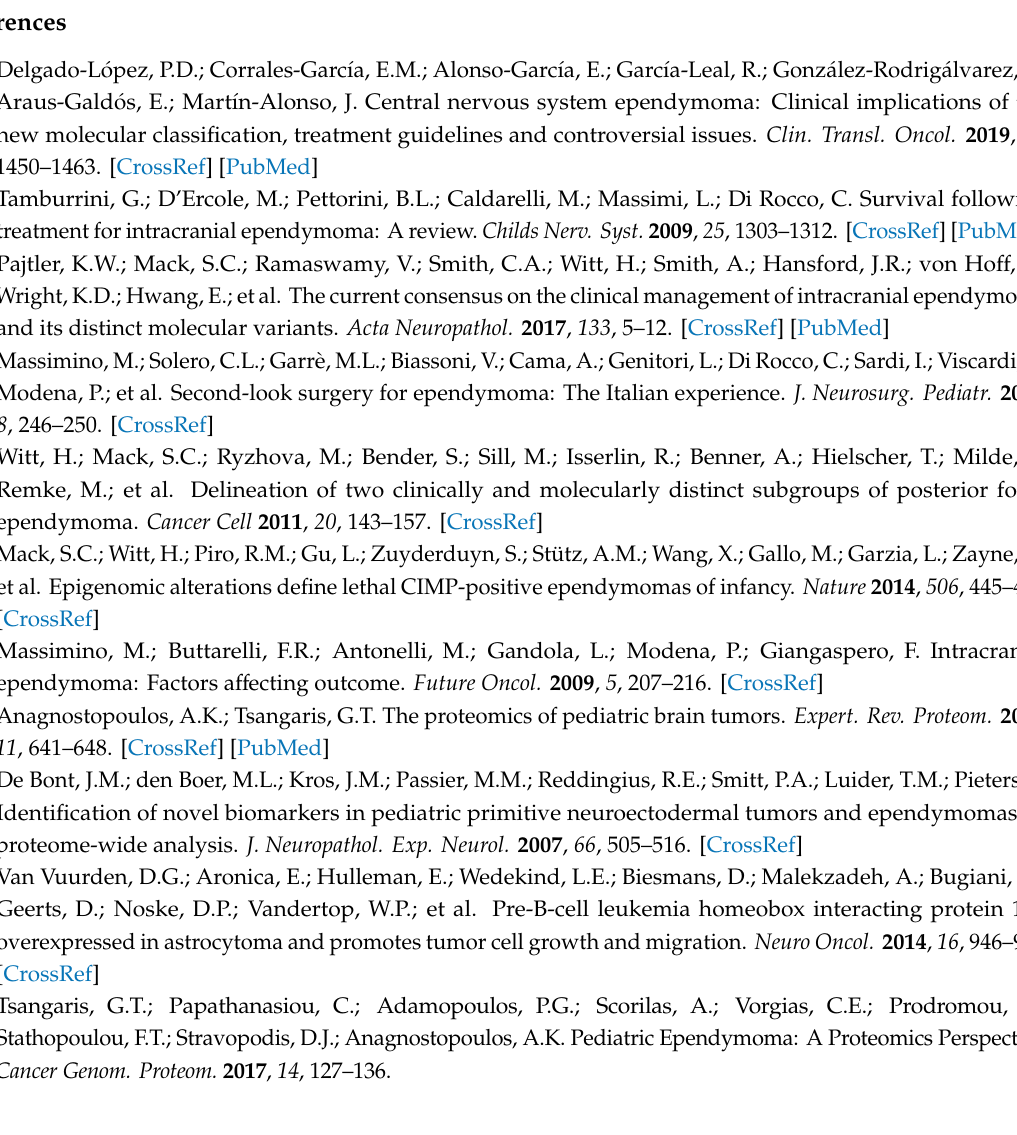
Table S1: Top down identification data of the proteins and peptides listed in Table 1 as resulting from MS / MS theoretical / experimental spectra matches, Figure S1: Relative quantitation of the proteins, identified by top-down approach, exhibiting a p value < 0.01 statistically significant variation between ST- and PF-EPs, Table S2: Protein identification data per analyzed specimens following MS / MS data elaboration by Proteome Discoverer software, Table S3: (A–E): Uniprot accession list of the protein identified in each analyzed sample by shotgun proteomic analysis (A), Venn diagram grouping of the proteins identified per sample (B), Venn diagram grouping of the proteins identified in grade II PF-EPs (C), Venn diagram grouping of of the proteins identified in grade III PF specimens (D), full list of the pathways classified and overrepresented in grade II and grade III PF-EPs